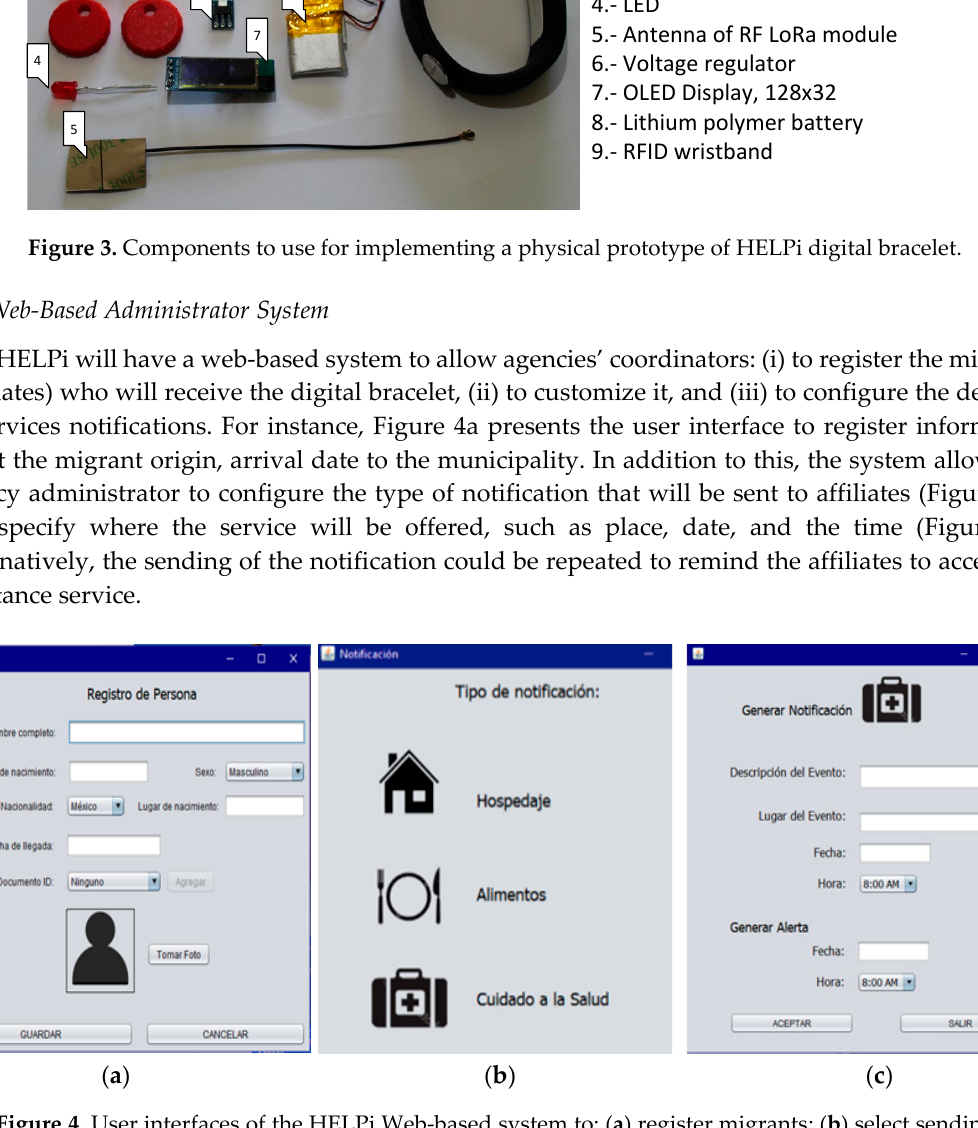
Figure 4. User interfaces of the HELPi Web-based system to: ( a ) register migrants; ( b ) select sending a service notification; ( c ) configure the notification to